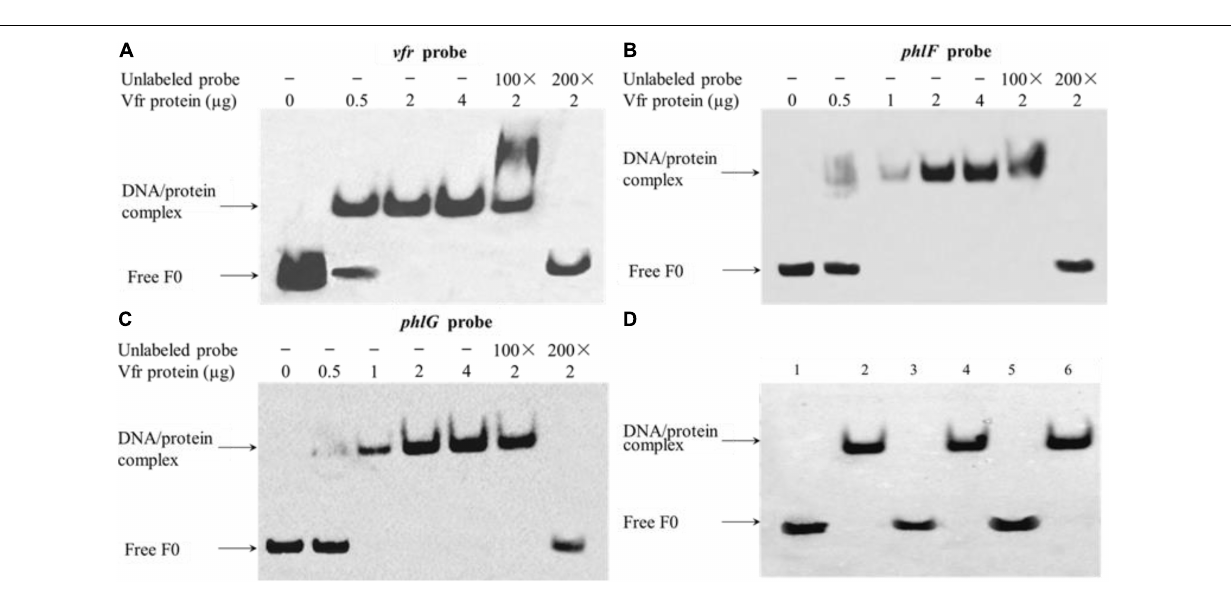
FIGURE 5 | Vfr binds specifically to the vfr , phlF and phlG upstream regions. Recombinant Vfr protein was incubated with biotin-labeled probes (A–C) or with smaller probes (D) for 20 min before electrophoresis. The amount of Vfr used in the assay is shown above each gel. The amount of probe F0 used in each EMSA reaction was 0.02 µ M; where indicated, a 100- to 200-fold excess of unlabeled probe was added to the reaction mixture prior to incubation. Lanes: (1) vfr probe alone; (2) vfr probe plus Vfr; (3) phlF probe alone; (4) phlF probe plus Vfr; (5) phlG probe alone; (6) phlG probe plus Vfr. Arrows indicate the positions of unbound free probes and Vfr-probe